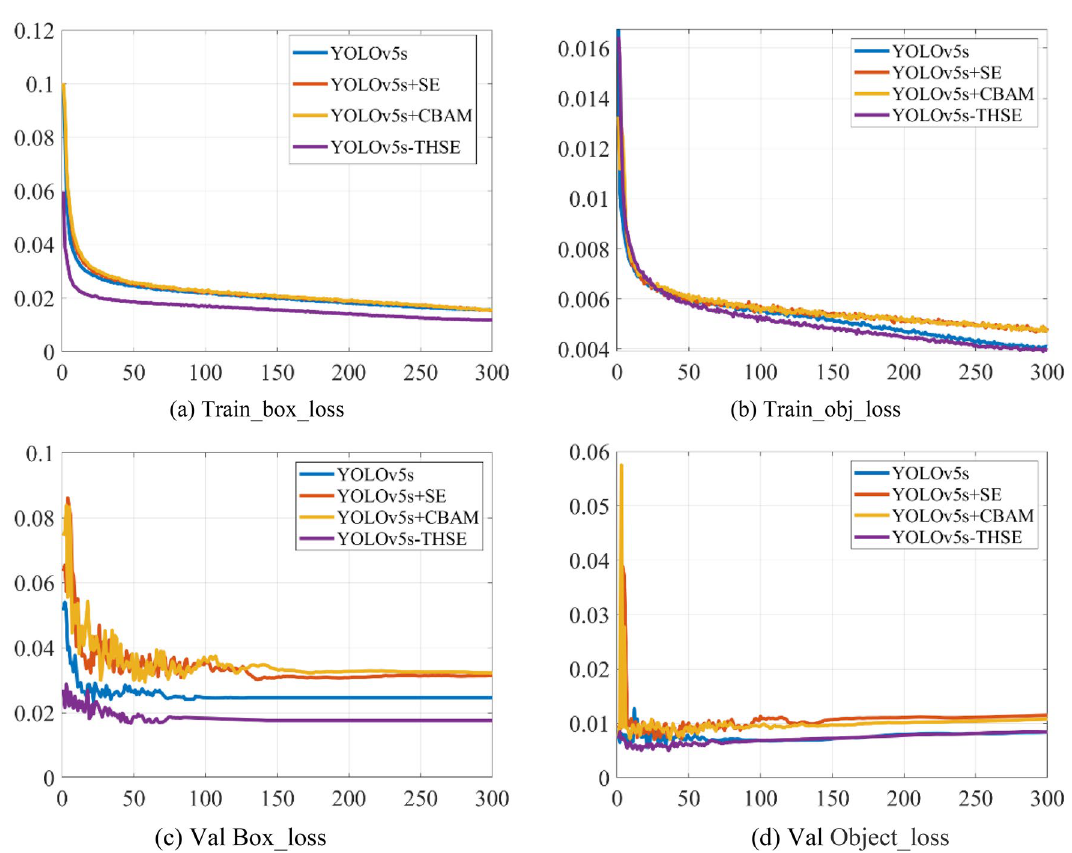
Figure 10. Comparison of loss function values of different models on training set and verification set. ( a ) Train_box_loss, ( b ) Train_obj_loss, ( c ) Val Box_loss, ( d ) Val